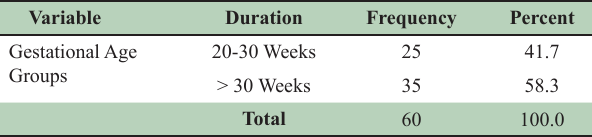
Table-I: Demographic characteristics of study population according to different age groups and gestational age